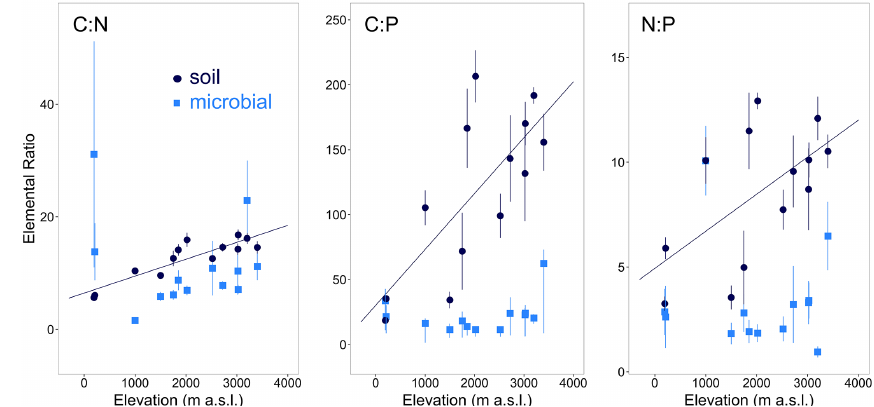
Figure 2. The relationships between soil and microbial C:N:P stoichiometry with elevation (194–3400ma.s.l.). Total soil C:N, C:P and N:P all significantly varied with elevation ( R 2 = 0.45, 0.36, 0.28, respectively p <0.05; see Table 2). Microbial C:P, C:N and N:P ratios did not vary with elevation. Values are means ± 1 SE ( n = 5 replicates, which represents the spatial variation within a 1ha plot). Table 3. Carbon (C), nitrogen (N) and phosphorus (P) and their ratios in soil microbial biomass along the elevation gradient. Linear model results (elevation ∼ property) are given at the bottom of the table. Values are means ± 1 SE ( n = 5). Site Elevation Microbial C Microbial N Microbial P Microbial C:N Microbial C:P Microbial N:P code